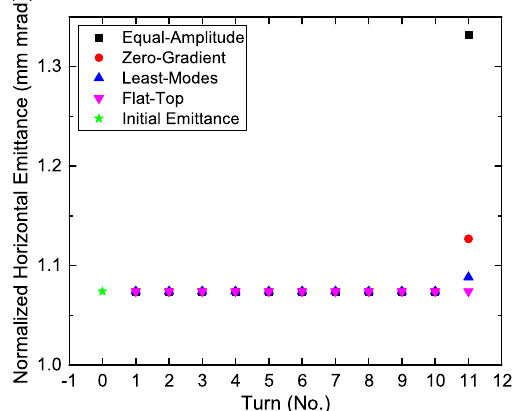
FIG. 10. Turn-by-turn normalized horizontal emittance growth for a single electron bunch with a predistortion kicker to compensate the nonuniform kicking pulse but no postdistortion